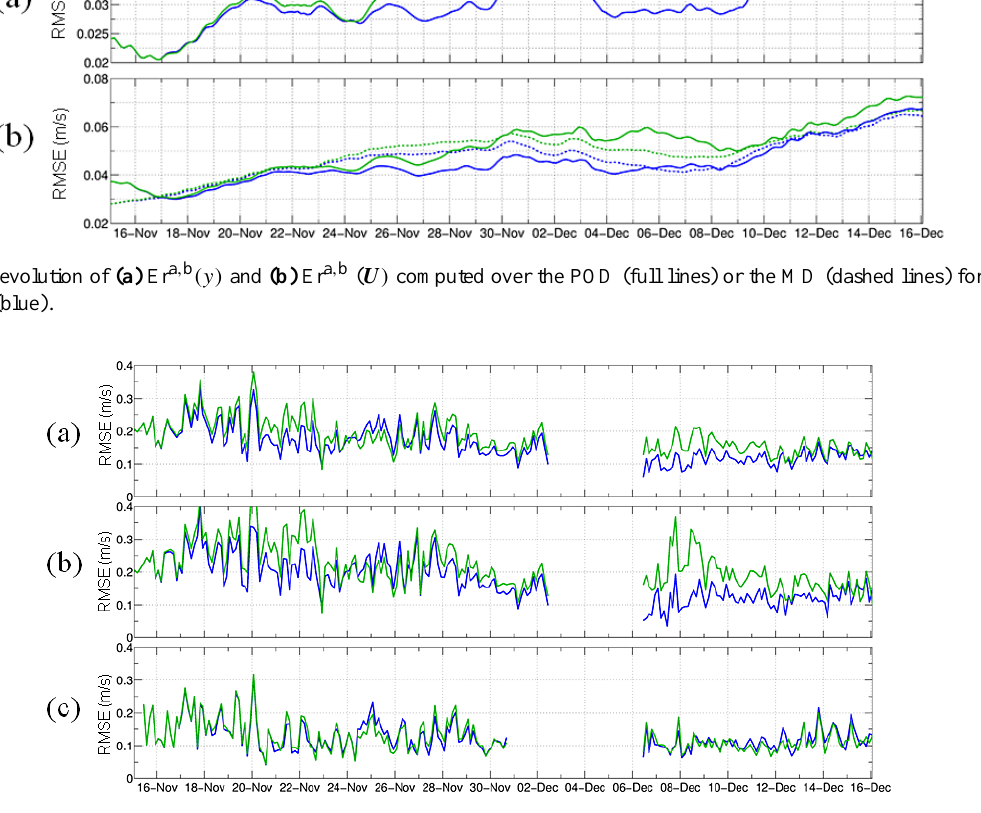
Table 2. T obc , S obc , U obc , V obc and η obc statistics computed for ObcTE between control and free or analyzed OBC values over the assimilation period. Er unit depends on physical parameters. Sc is without unit.